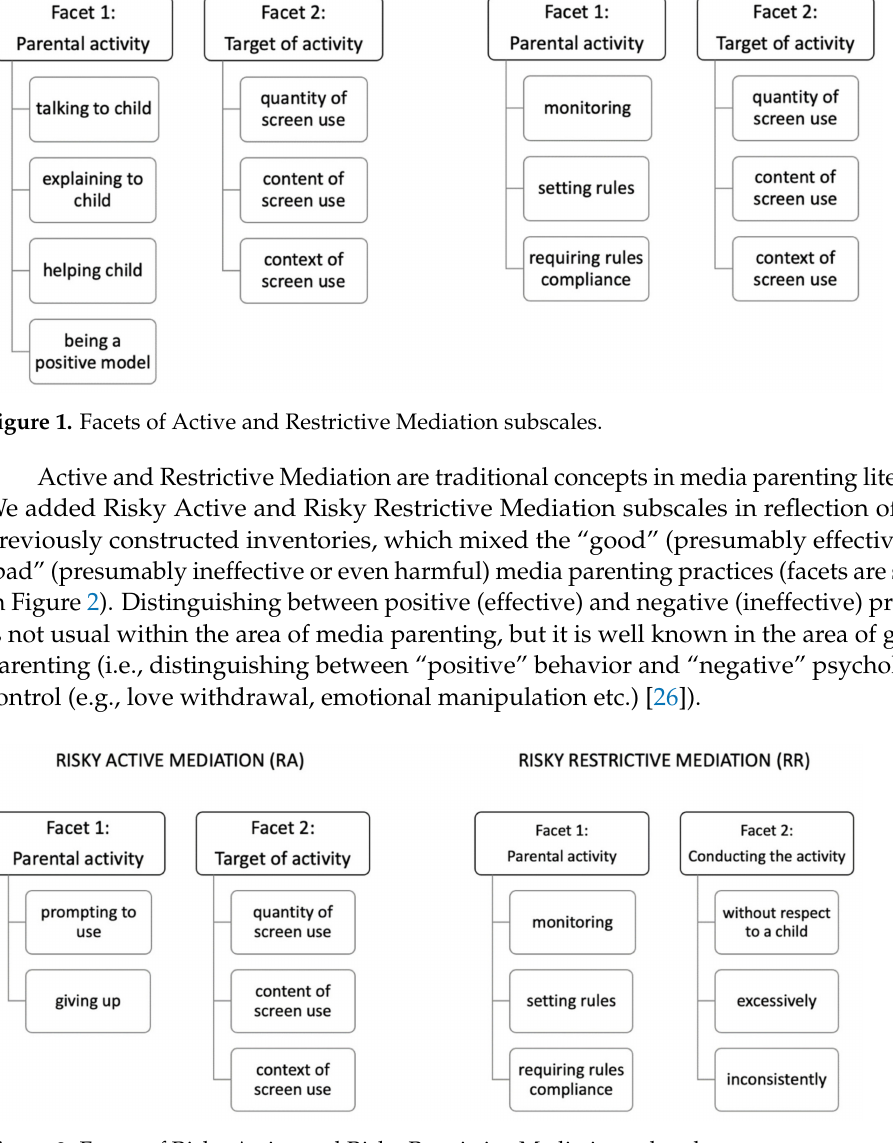
Figure 2. Facets of Risky Active and Risky Restrictive Mediation